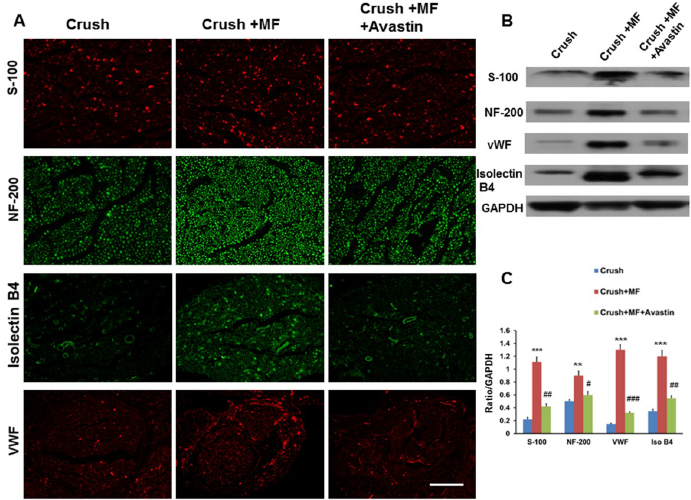
Fig 6. Increased nerve regeneration and angiogenesis by the muscle flap rotation. (A) The representative of crushed nerve in the expression of S-100, NF, isolectin B4, and vWF in various treatment groups. (B) A representative of western blot showing expression of S-100, NF, isolectin B4, and vWF in the various treatment groups. (C) Quantitative analysis of S-100, NF, isolectin B4, and vWF in the various treatment groups. Crush, Crush+MF, Crush+MF+Avastin: see text. � p < 0.05, �� p < 0.01 indicated the Crush+MF related to Crush, # p < 0.05 indicated Crush+MF+Avastin related to Crush+MF. Arrow bar length = 100 μ m.